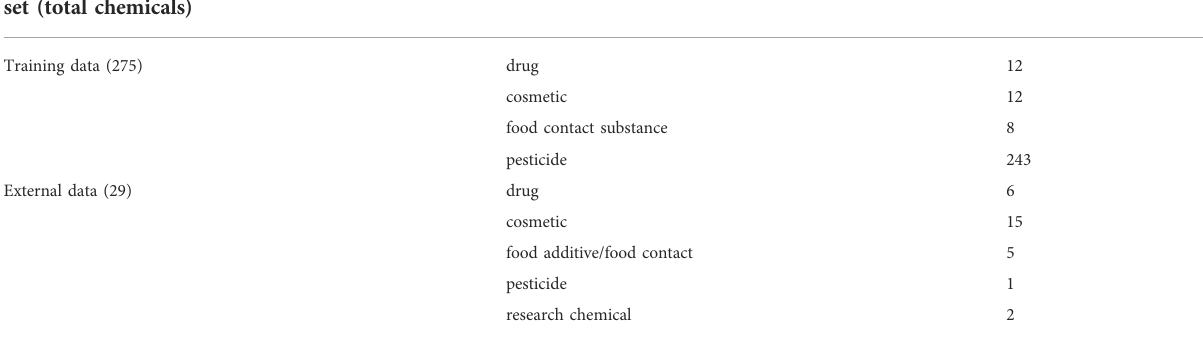
TABLE 1 Chemical category distribution of the training dataset and external validation